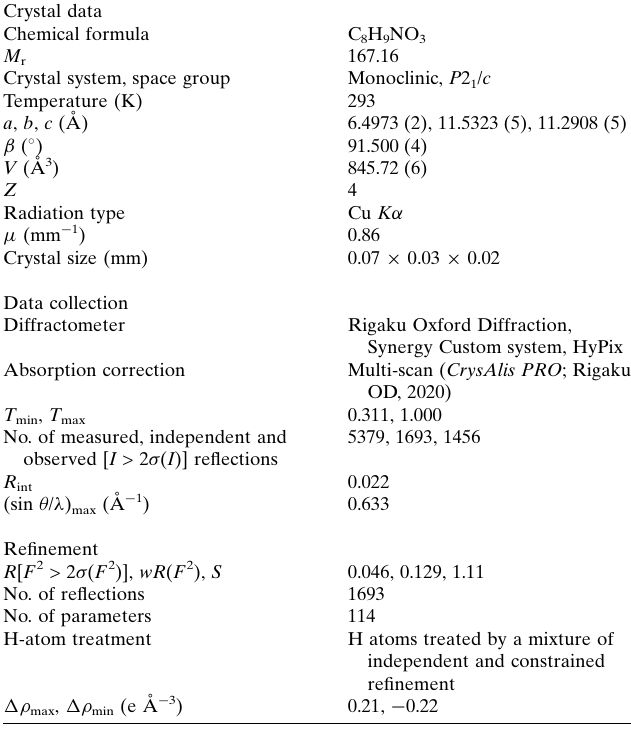
Table 1 Hydrogen-bond geometry (A˚ , (cid:3) ).